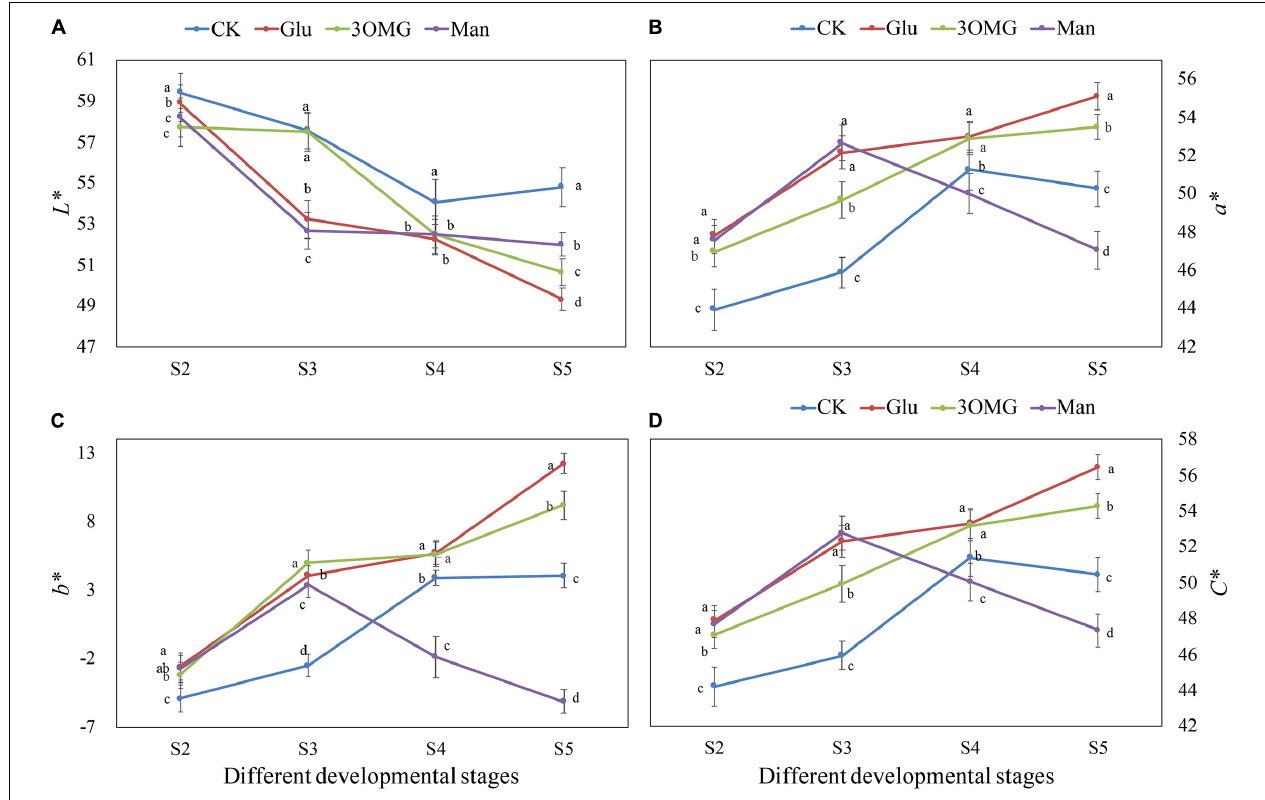
FIGURE 2 | The flower color values of P. suffruticosa ‘Tai Yang’ cut flowers under four treatments. (A) Lightness ( L* ). (B) Redness ( a* ). (C) Yellowness ( b* ). (D) Chroma ( C* ). There were four treatments including CK, Glu, 3OMG, and Man, respectively. CK was the control group that cut flowers treated with distilled water. Glu, 3OMG, and Man were the cut flowers treated with glucose, 3-O-methylglucose, and mannose at 333 mM, respectively. S2, pre-opening stage; S3, initial opening stage; S4, half opening stage; S5, full opening stage. Each value was expressed as the mean ± standard errors (SE) of triplicate replications. Different small letters indicated significant differences among treatments at the same developmental stage according to Duncan’s multiple range test at p <